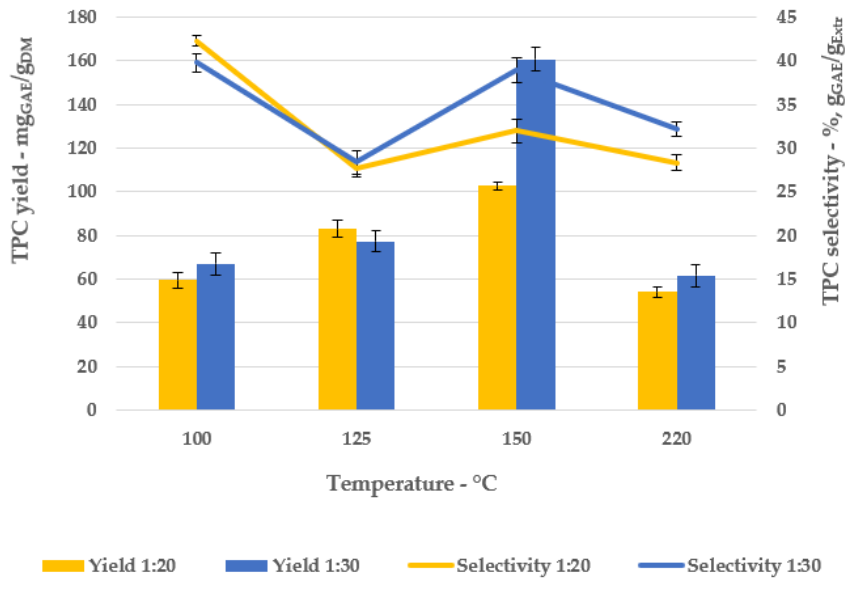
Figure 3. TPC, yield, and selectivity.